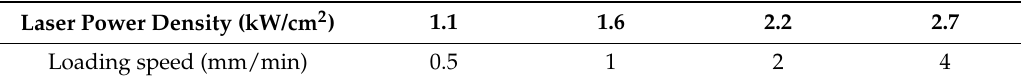
Table 3. Experimental parameters: laser power densities and loading